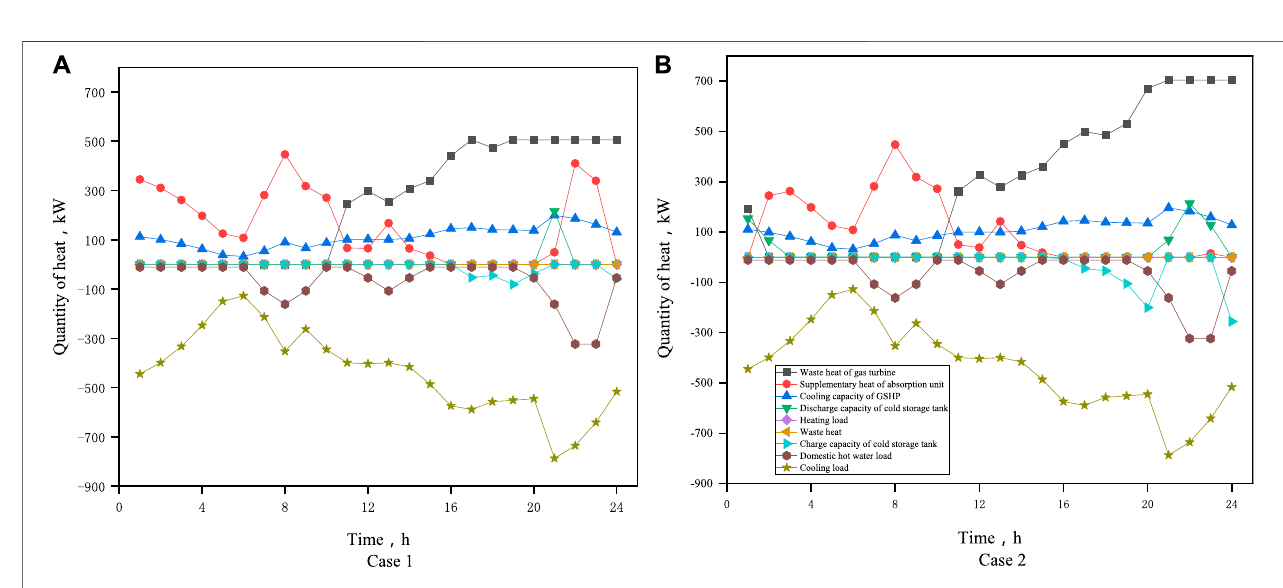
FIGURE 10 | Comparisons of operational modes of thermal components in a typical summer day considering different objectives.